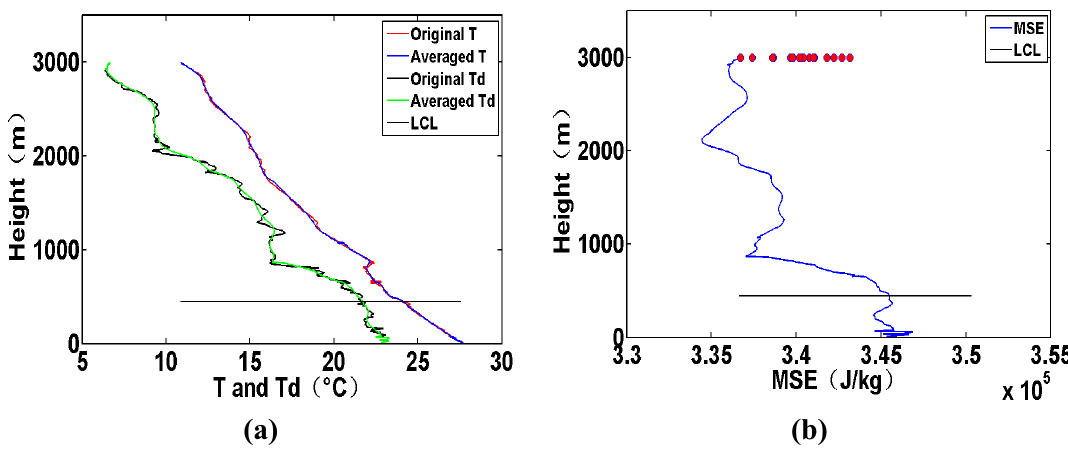
Figure 2. Aircraft vertical sounding of R28 case: ( a ) Temperature ( T ) and dew-point temperature ( T d ) and ( b ) moist static energy (MSE), and the black horizontal lines represent the heights of LCL; the red points in ( b ) represent the mean MSE values in each cloud.